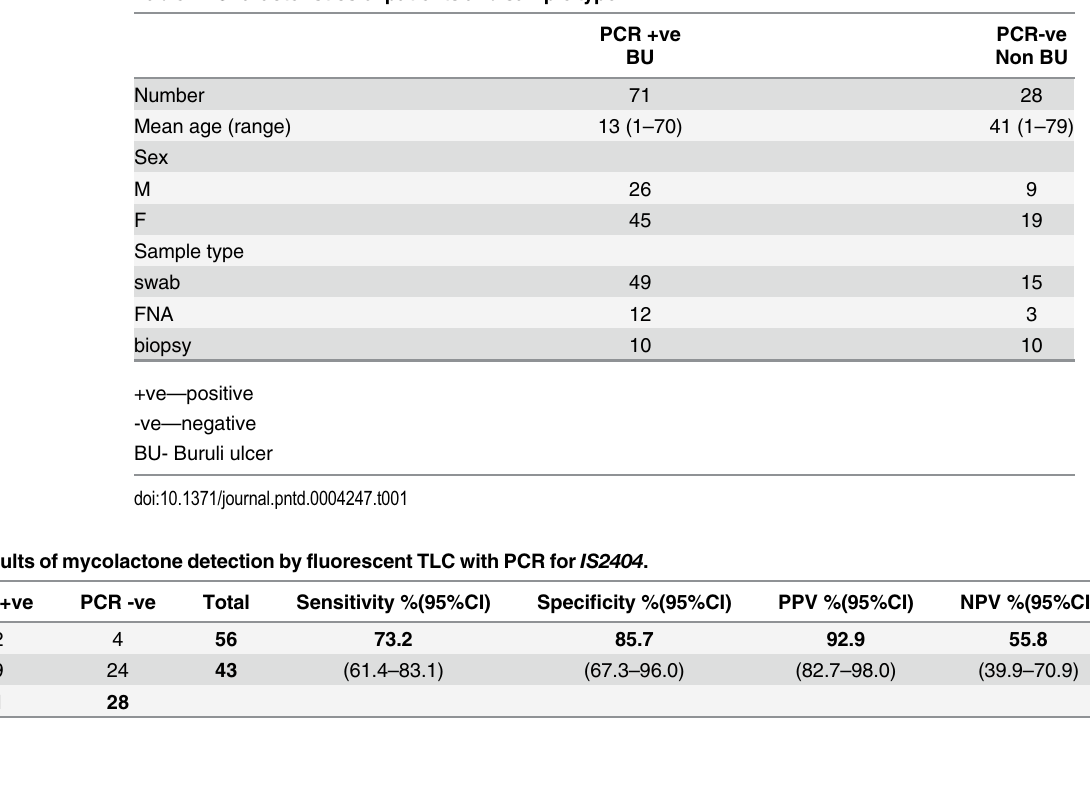
Table 1. Characteristics of patients and sample type.